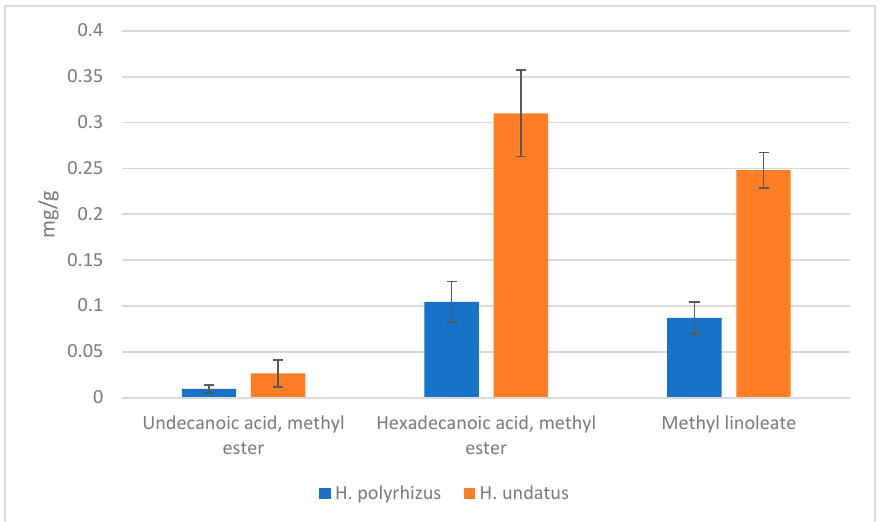
Figure 2. Identification of Gas-chromatography-mass spectrometry (GC-MS) analysis in Selenicerus undatus and Hylocereus polyrhizus . The average represents the value of 3 repetitions.